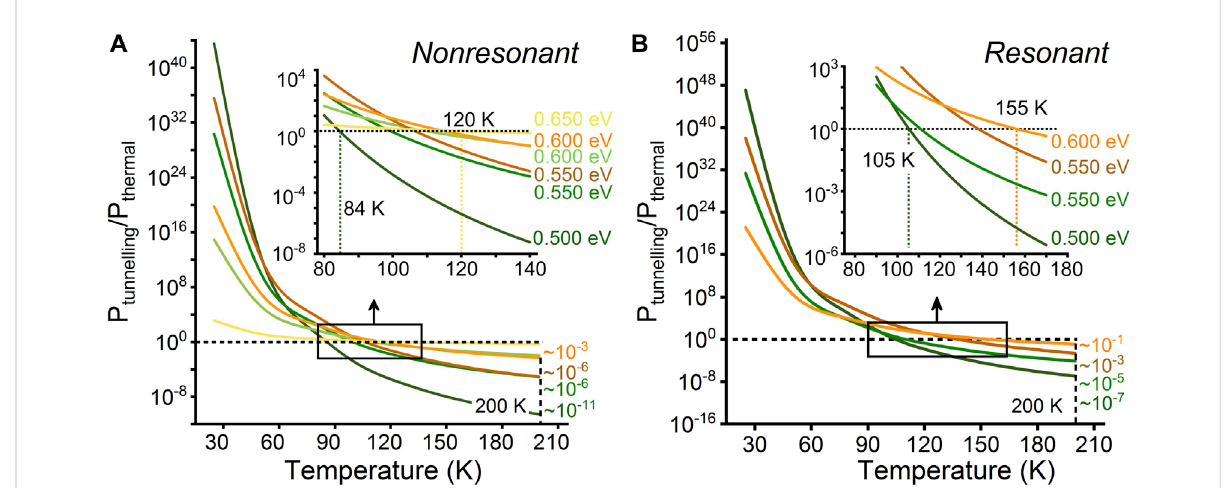
FIGURE 2 Ratio of the tunnelling probability to the thermal disturbance probability for the water chain in the CNT to achieve reorientation at certain provided energies anddifferenttemperatures. (A) Coherence isnot considered inthetunnelling probabilitycalculation. (B) Coherenceisconsidered in the tunnelling probability calculation. The temperature range is 25 – 200 K, and the interval is 25 K “ ~ ” is the